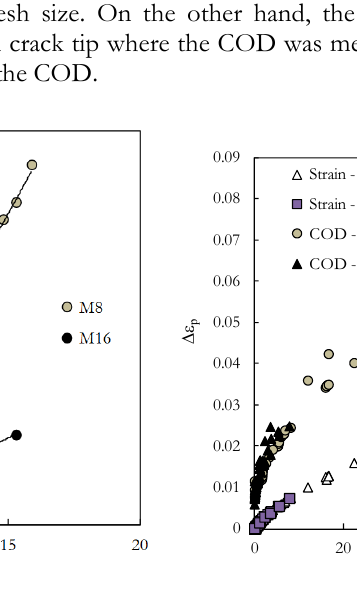
Figure 4: Effect of mesh on plastic strain range. Figure 5: Crack opening displacement versus energy and plastic strain range versus